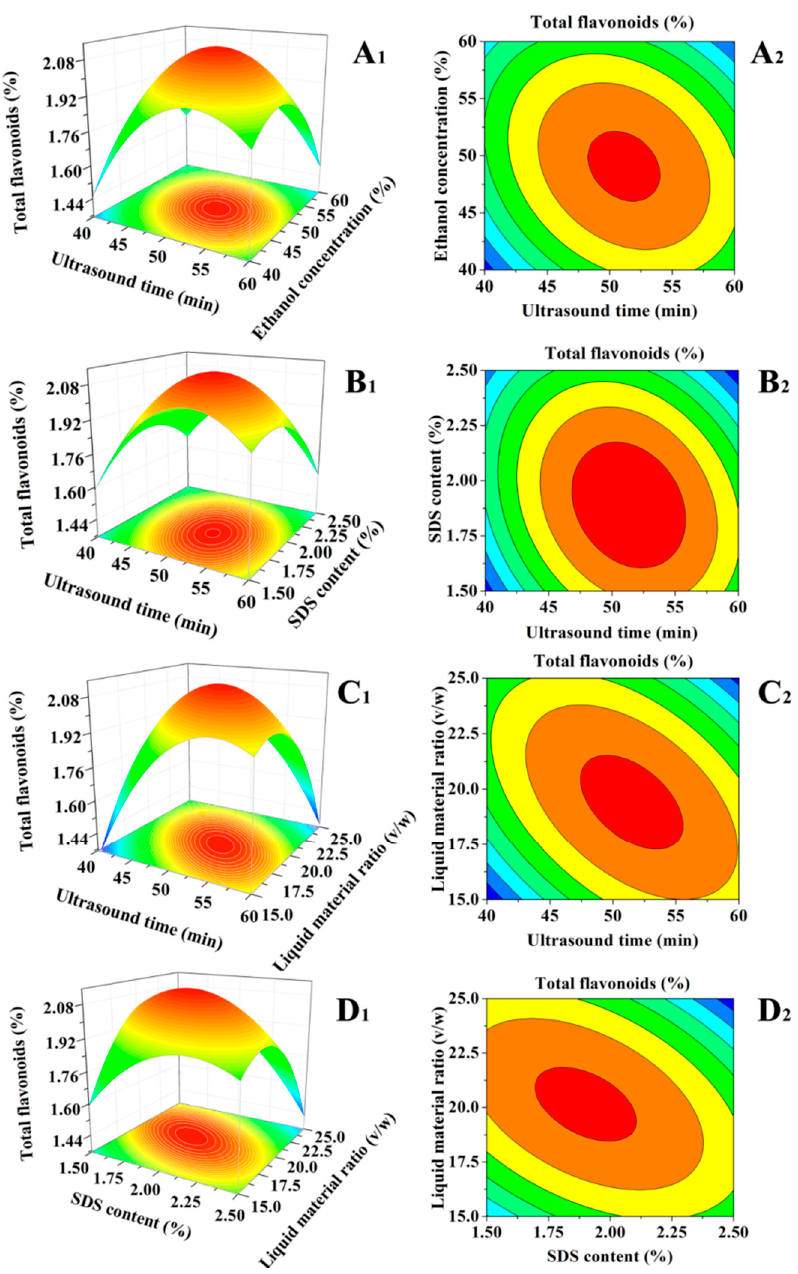
Figure 4. Response surface for the effect of operating parameters on total flavonoid contents; ( A 1 ) ultrasound time vs. ethanol concentration; ( B 1 ) ultrasound time vs. an SDS content; ( C 1 ) ultrasound time vs. liquid material ratio ( v / w ); ( D 1 ) an SDS content vs. liquid material ratio ( v / w ). ( A 2 – D 2 ) are their contour plots, respectively.